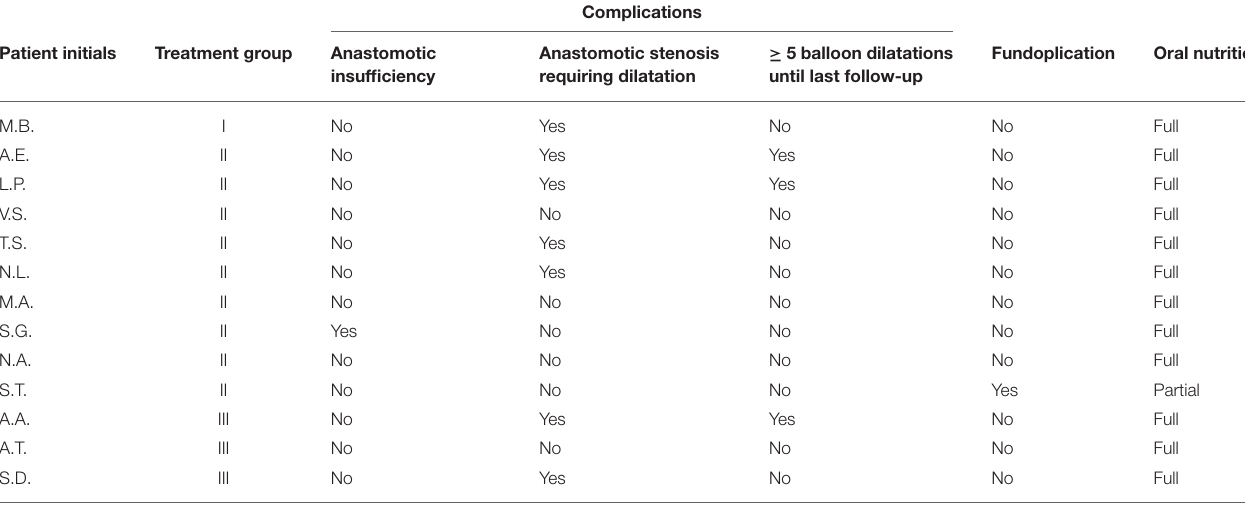
TABLE 2 | Postoperative complications and functional